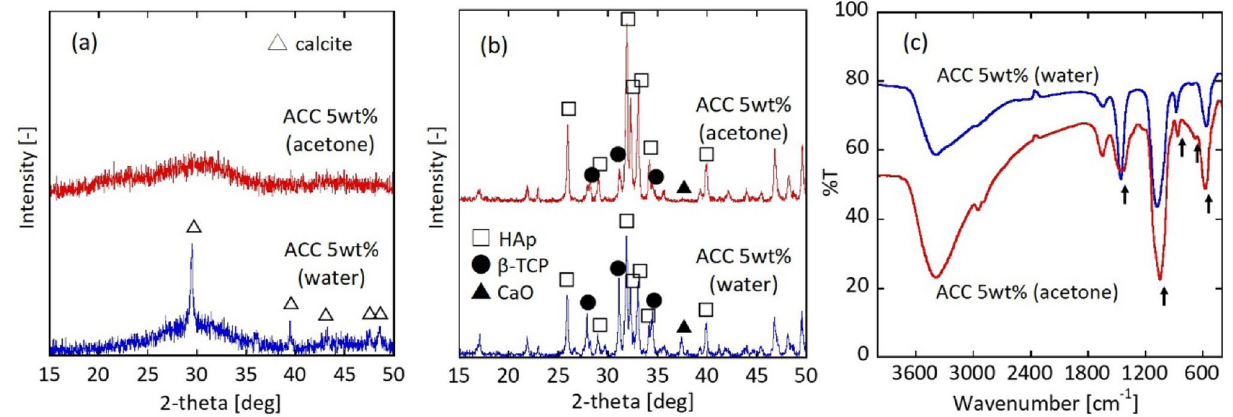
Figure 1. XRD patterns of ( a ) pre-calcined and ( b ) calcined particles. Peak positions in the XRD profiles correspond to those of calcite (JCPDS no. 05-0586), hydroxyapatite (JCPDS no. 09-0432), β-TCP (JCPDS no. 09-0169)), and calcium oxide (JCPDS no. 37-1497). ( c ) FTIR spectra for the pre-calcined sample. Phosphorylation reaction is carried out in water and acetone systems using 5 wt% ACC colloid (Ca/P = 1.68).